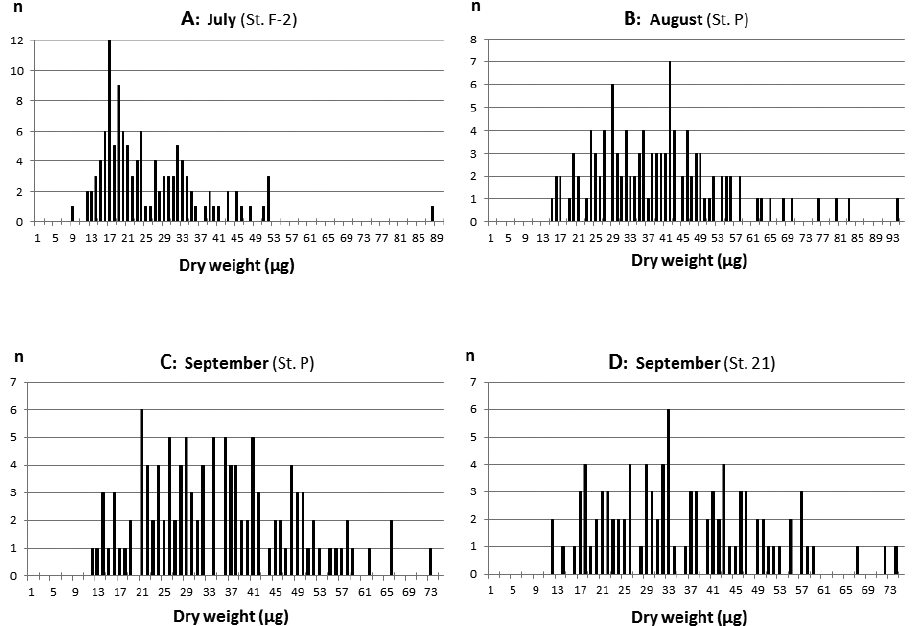
Figure 2. Frequency distribution ( n ) of Cercopagis pengoi individuals with different dry weight (µg) at three stations in the eastern Gulf of Finland in July ( A ), August ( B ) and September ( C, D